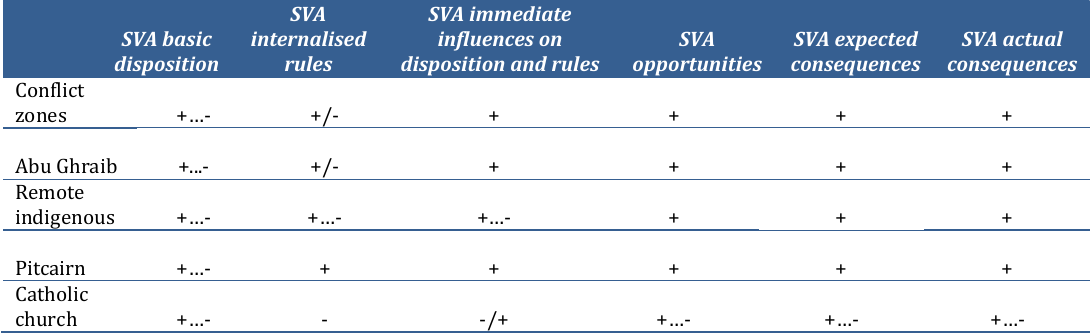
Table 1: The causal model for endemic sexual violence and abuse as it relates to five case studies SVA SVA immediate SVA basic internalised influences on disposition rules disposition and rules